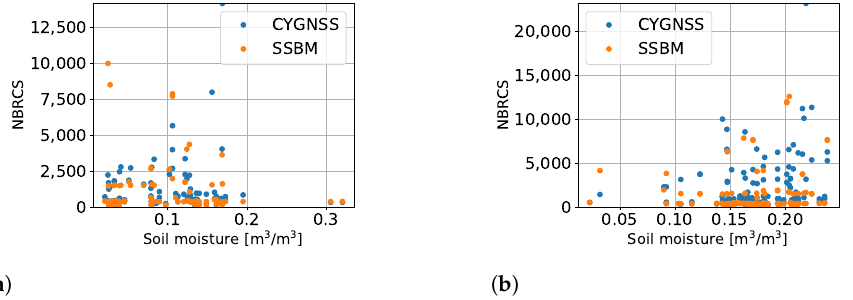
Figure 14. Averaged NBRCS values of CYGNSS and SSBM, for all DDMs used in this study. ( a ) Year 2019. ( b ) Year 2020.